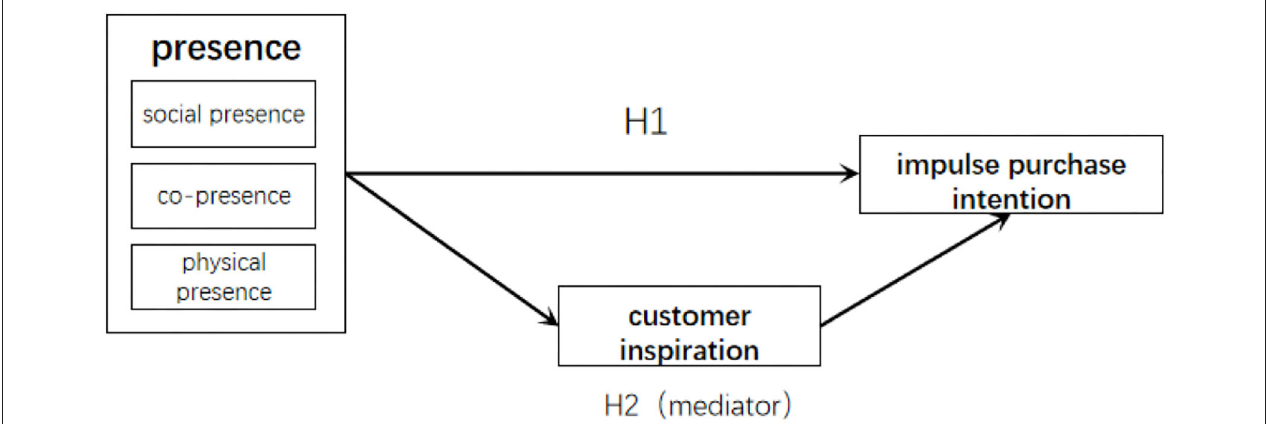
FIGURE 1 | Conceptual model.